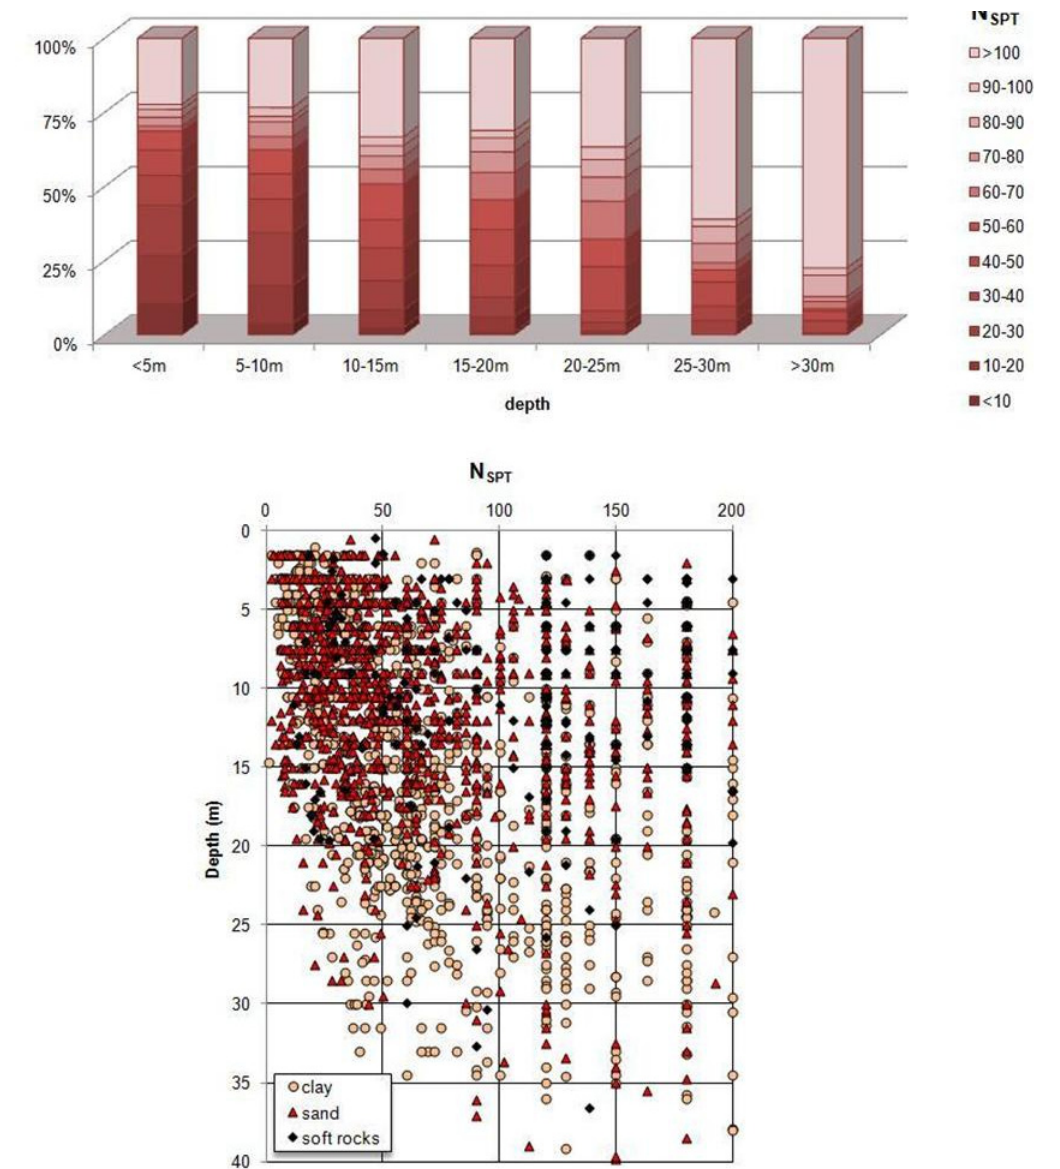
values in the Miocene bedrock (excluding 10% of the tests with N Figure 6. Distribution of N SPT tograms of N values for different depths. Bottom: distribution of N SPT